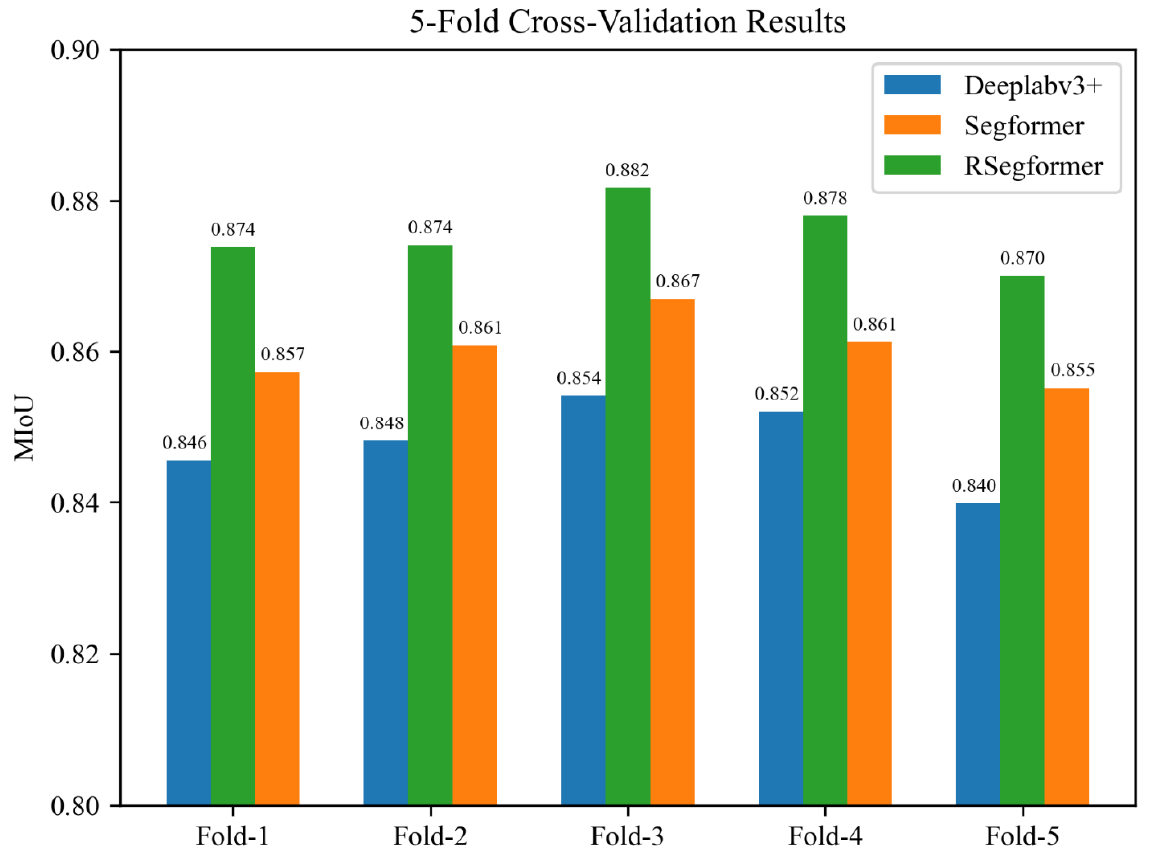
Figure 7. MIoUs for the three models were validated using 5-fold cross-validation. The dataset was divided into 5 parts, set as data-1 to data-5. fold-i is equal to the experimental results obtained by treating data-i as the validation set and the rest of the data as the training set.